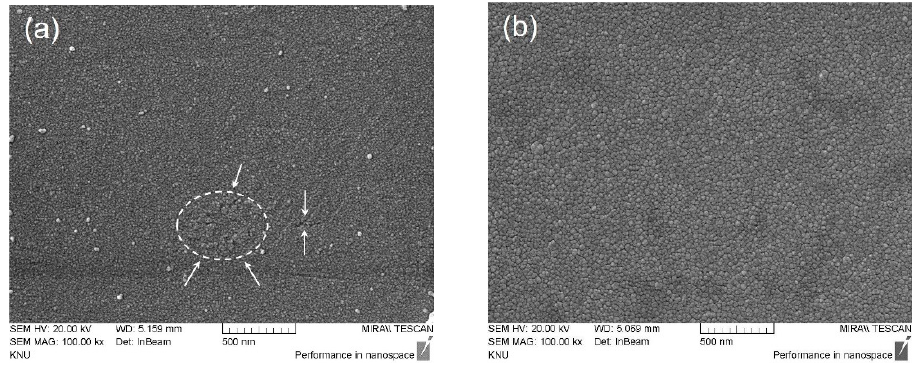
Figure 3. Field-emission scanning electron microscopy ( FE-SEM) images of Si/sapphire: ( a ) as-deposited and ( b ) oxidized at 823 K.